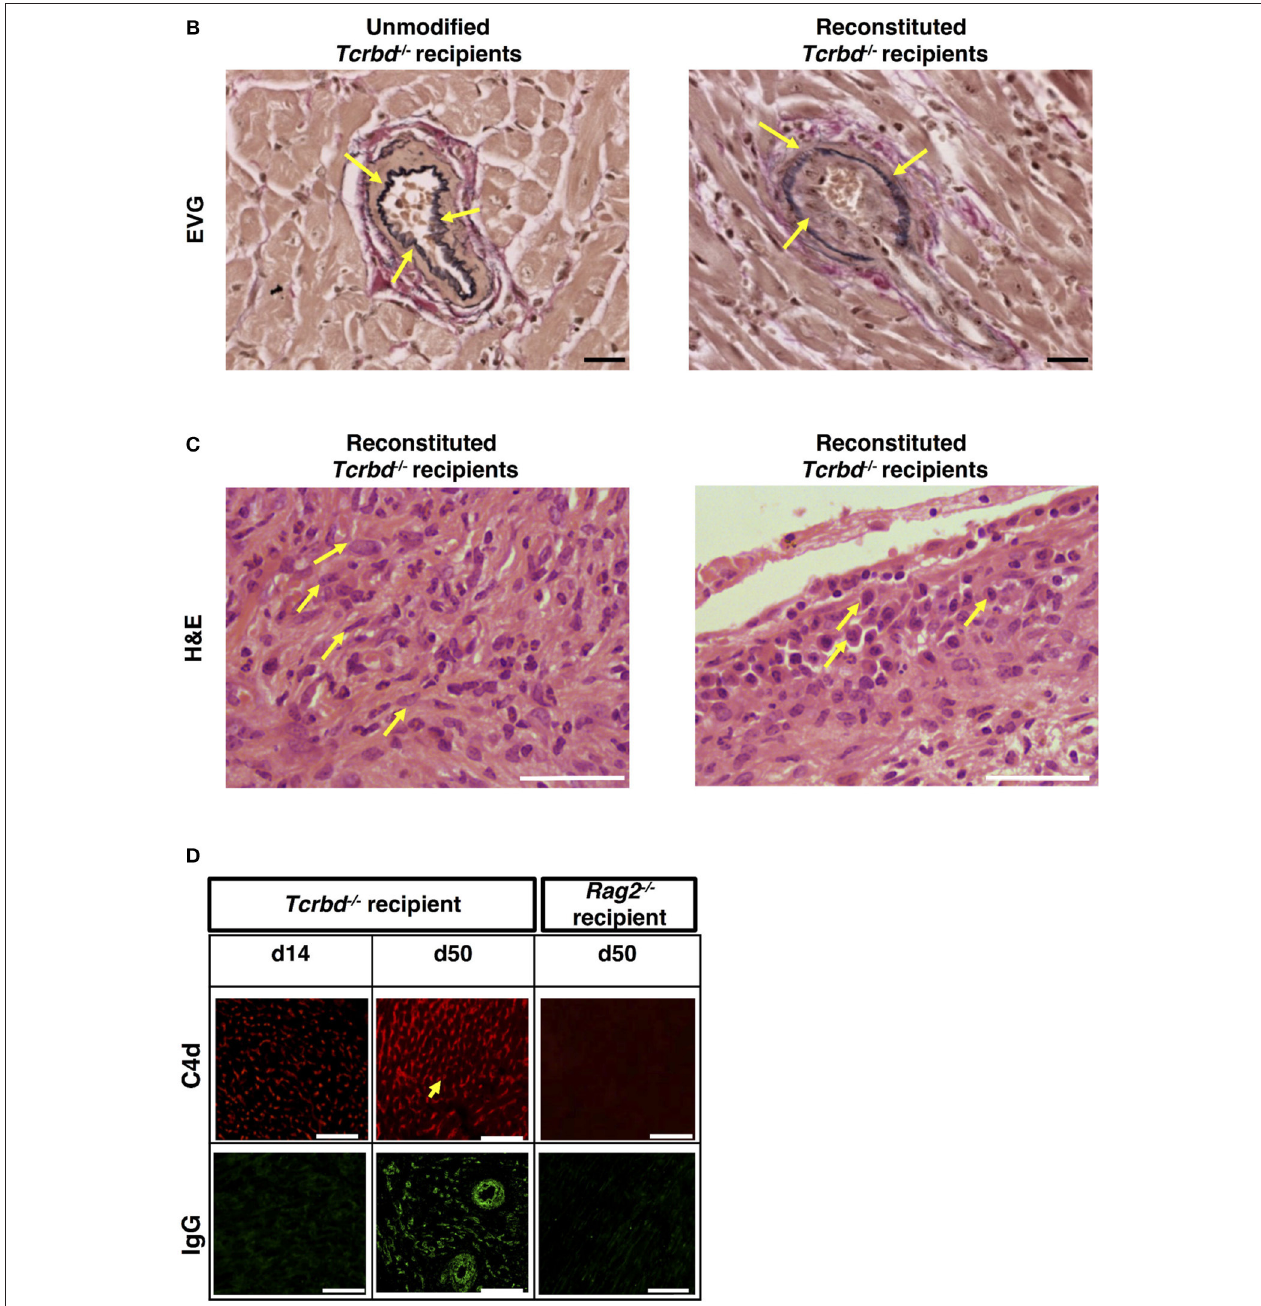
FIGURE 2 | Histopathological confirmation of humoral rejection. (A) Representative photomicrographs of BALB/c hearts explanted at d50 from BL/6 Tcrbd − / − recipients (reconstituted with 10 3 wild-type [WT] TCR75 CD4T cells) demonstrate: inflammatory infiltrates with myocyte loss and replacement fibrosis (on H&E staining); endothelial complement C4d deposition and areas of CD68 + (macrophage) and NK1.1 + (NK cell) staining, compared with grossly normal histology and negative staining in equivalent grafts from unmodified (not reconstituted) BL/6 Tcrbd − / − recipients and BL/6 Tcrbd − / − recipients reconstituted with Sh2d1a − / − (SAP − / − ) TCR75 CD4T cells. Representative photomicrographs of (B) elastin van Gieson stained sections of d50 allografts from the wild-type reconstituted group depicting fibroproliferative arterial intimal thickening, compared to control unmodified Tcrbd − / − recipients, and (C) H&E stained sections demonstrating inflammatory infiltrates consisting predominantly of (left) polymorphs and (right) occasional plasma cells (arrows). (D) Representative photomicrographs of immunofluorescence staining showing interstitial capillary/vascular staining (arrowed) for C4d (red) and IgG deposition (green) in BALB/c cardiac allografts explanted at days 14 and 50 from BL/6 Tcrbd − / − recipients reconstituted with 10 3 WT TCR75 CD4T cells, and at day 50 from WT reconstituted Rag2 − / − recipients. Intensity of C4d and IgG staining increased from day 14 to day 50 in Tcrbd − / − recipients reconstituted with WT TCR75 CD4T cells. All images are representative of at least 5 animals: scale bars–A: 50 µ m (H&E, CD68, and NK1.1 images, except for the NK1.1 image of the reconstituted BL/6 Tcrbd − / − group which is at 75 µ m) or 100 µ m (C4d images), B: 100 µ m, C: 150 µ m, and D: top row; scale bar- − 50 µ m; bottom row; scale bar − 100 µ m.